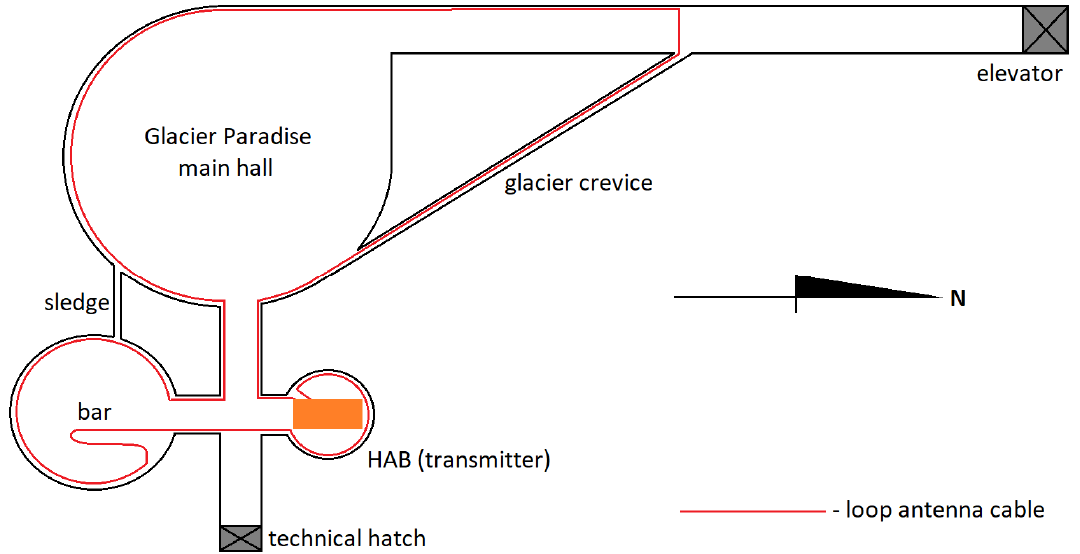
Figure 2. A simplified floorplan of the Glacier Paradise premises inside the Klein Matterhorn glacier, with the 270 kHz antenna cable installed.